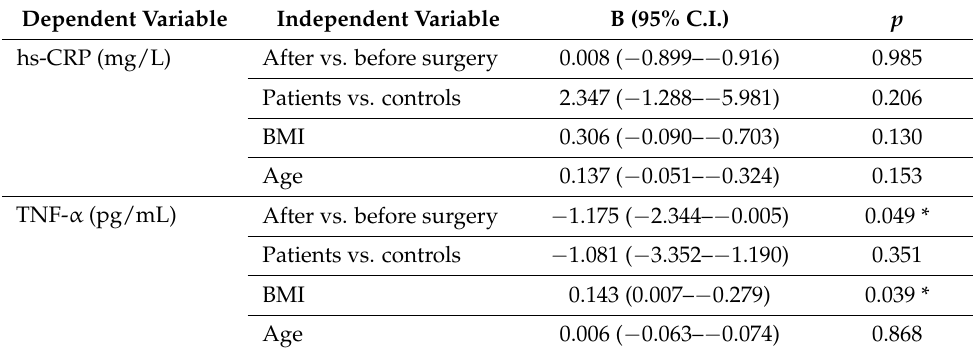
Table 3. Results of the generalized estimating equations (GEE) models to assess the effect of change in the BMI and age on the marker levels after the surgery is presented as estimates, confidence interval (C.I.) and the level of significance ( p ). Dependent Variable Independent Variable B (95% C.I.) After vs. before